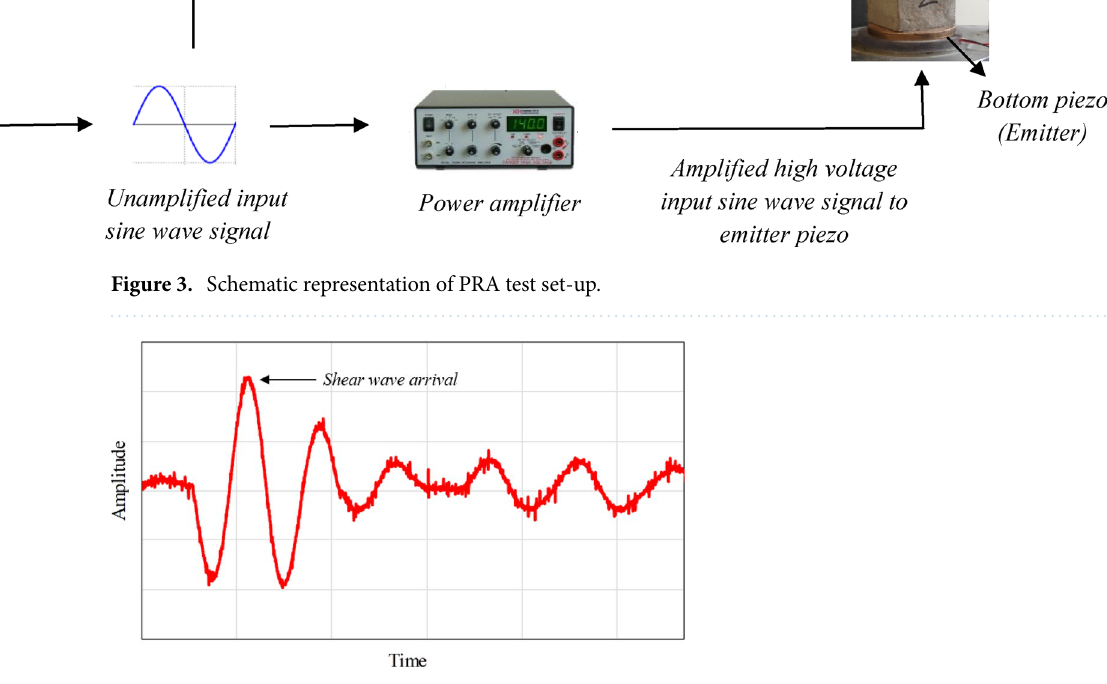
Figure 4. Typical output signal with clear shear wave arrival.